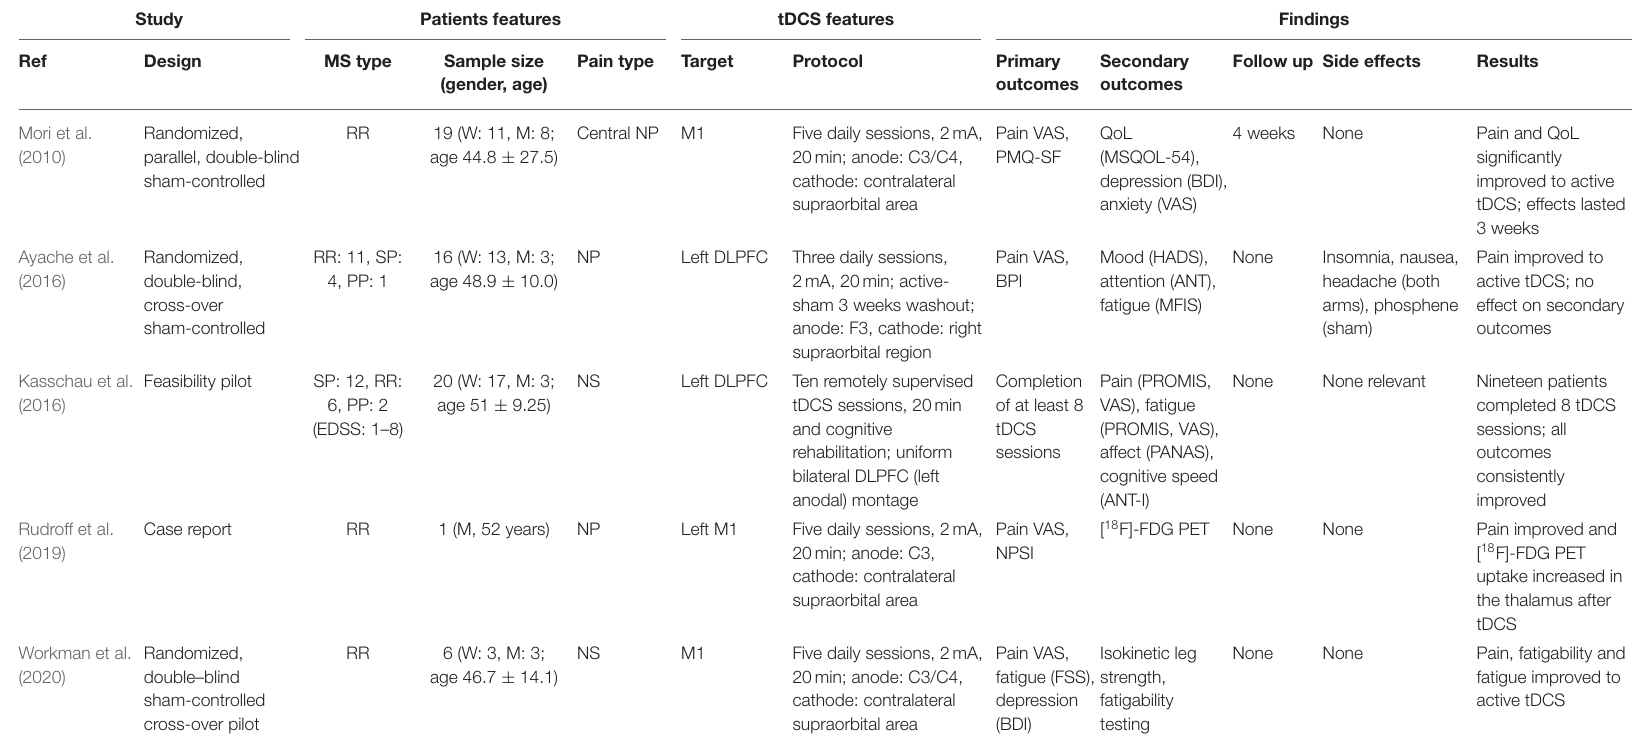
ANT, Attention Network Test; ANT-I, Attention Network Test-Interaction; BDI, Beck Depression Inventory; BPI, Brief Pain Inventory; DLPFC, dorsolateral pre-frontal cortex; EDSS, Expanded Disability Status Scale; [ 18 F] FDG-PET, [ 18 F] fluorodeoxyglucose positron emission tomography; FSS, Fatigue Severity Scale; HADS, 14-item Hospital Anxiety and Depression Scale; M, men; mA, milliampere; MFIS, Multidimensional Fatigue Inventory Score; MPQ-SF, McGill pain questionnaire short form; MS, multiple sclerosis; MSQOL-54, Multiple Sclerosis Quality of Life-54 scale; M1, primary motor cortex; NP, neuropathic pain; NPSI, Neuropathic Pain Symptom Inventory; NS, not specified; PANAS, Positive and Negative Affect Schedule; PP, primary progressive; PROMIS, Patient Reported Outcomes Measurement Information System; QoL, quality of life; Ref, reference; RR, relapsing remitting; SP, secondary progressive; tDCS, transcranial direct current stimulation; VAS, Visual Analog Scale; W,